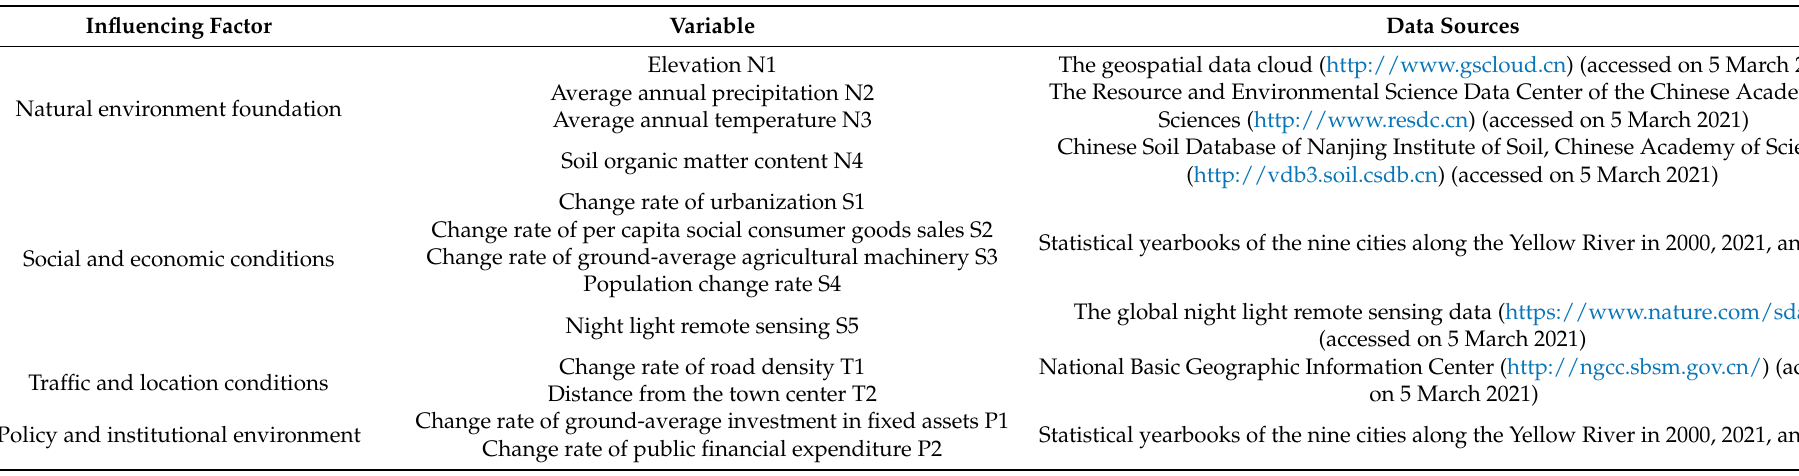
Table 1. Data sources of land use change influencing